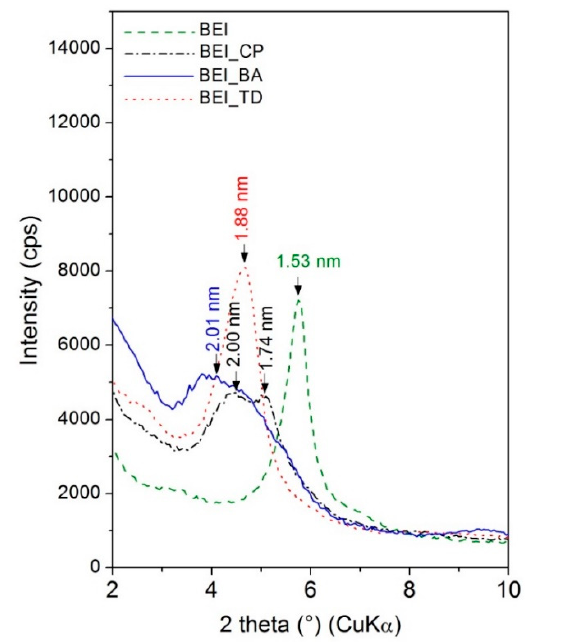
Figure 4. The comparison of XRD patterns of BEI, BEI_CP, BEI_BA and BEI_TD (from 2° to 10° 2 θ ).